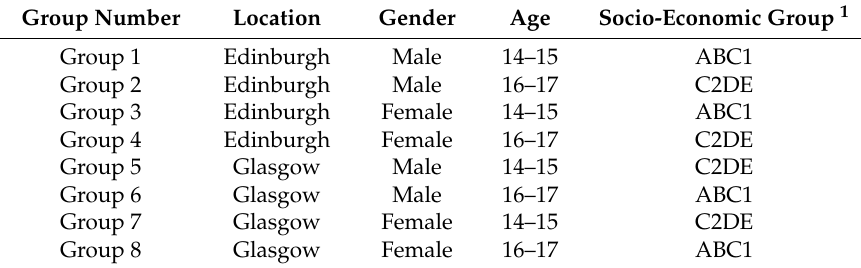
Table 1. Details of focus group participants.